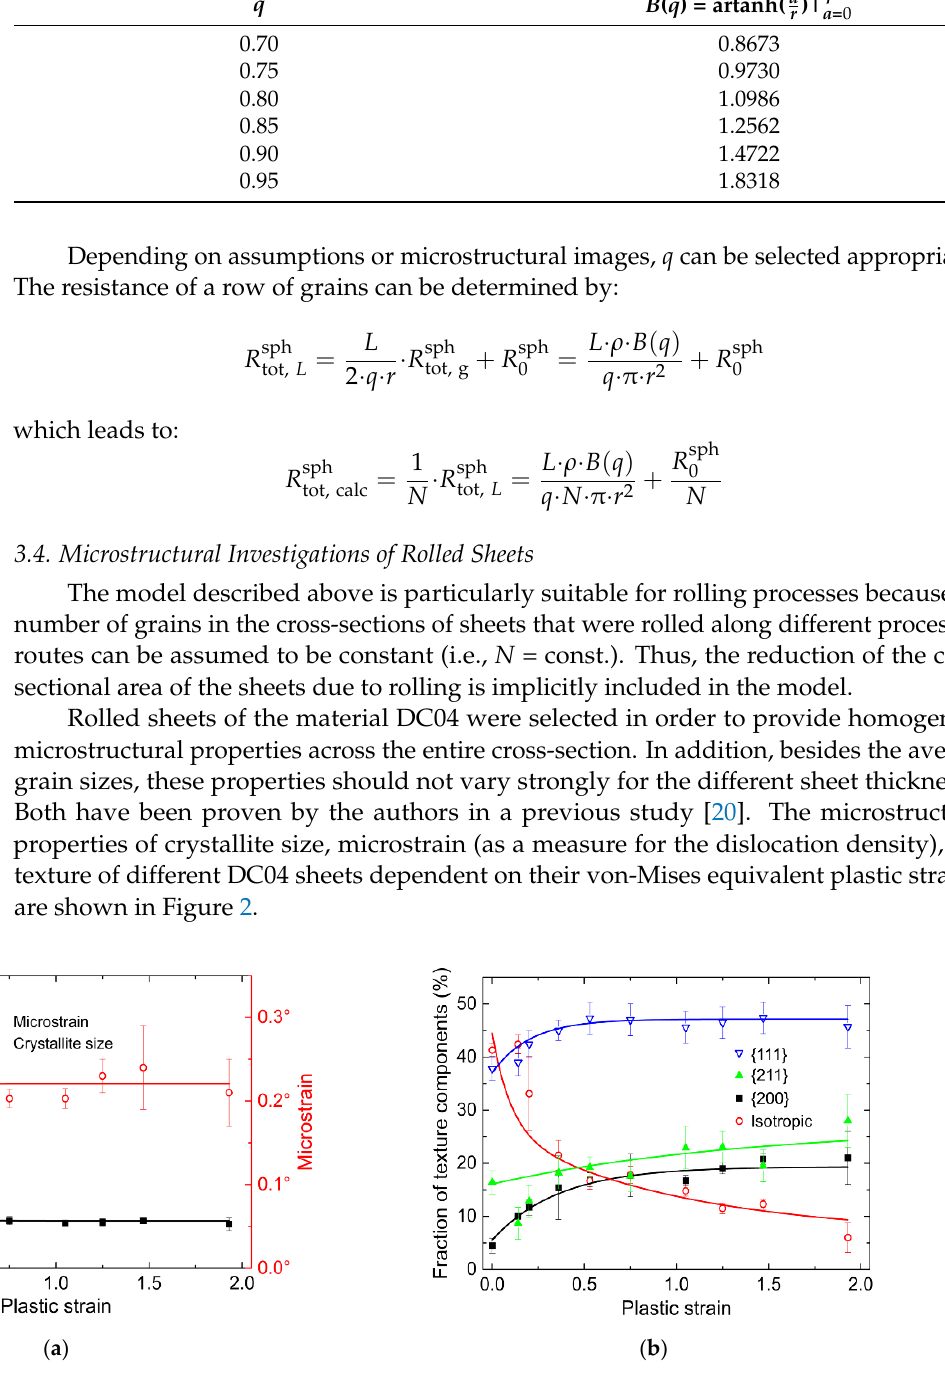
Figure 2. Crystallite sizes and microstrains ( a ) as well as fraction of different texture components ( b ) for different DC04 sheets with different von-Mises equivalent plastic strains. The solid lines are exponential fitting functions.